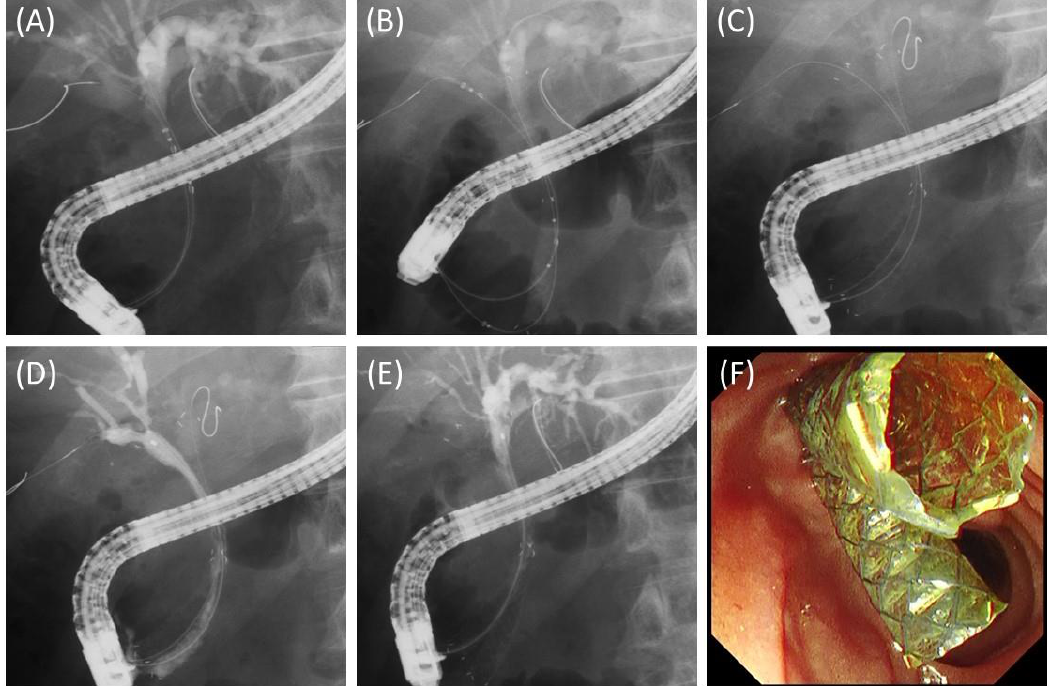
Figure 2. Deployment of two 8 mm FCSEMSs. ( A ) Two introducers were simultaneously inserted into the bile duct. ( B ) One stent was deployed in the left hepatic duct across the papilla. ( C ) Another stent was deployed in the right hepatic duct across the papilla. ( D ) Cholangiography after stent placement depicted all intrahepatic branches of the right hepatic lobe. ( E ) Cholangiography after stent placement depicted all intrahepatic branches of the left hepatic lobe. ( F ) Endoscopic view of two stents across the